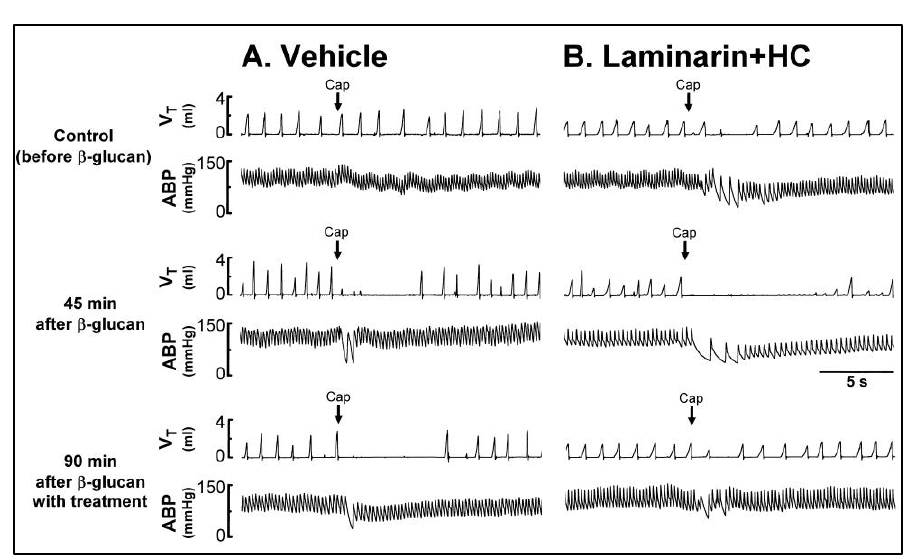
Figure 4. Experimental records illustrating the effect of treatment with ( A ) vehicle or ( B ) Laminarin (10 mg / kg, iv) + HC (8 mg / kg, iv) on the β -glucan-induced enhancement of pulmonary chemoreflex responses triggered by capsaicin injection (Cap, 1 µ g / kg; arrows) in two anesthetized, spontaneously breathing rats (vehicle: 340 g; Laminarin + HC: 325 g). V T , tidal volume; ABP, arterial blood pressure.